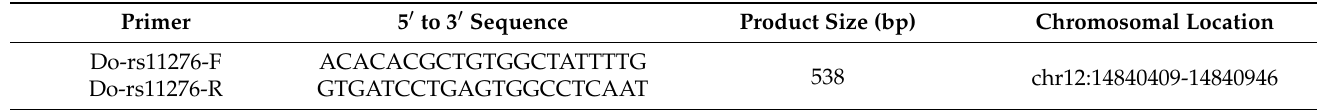
Table 1. DO primers used for sequencing.